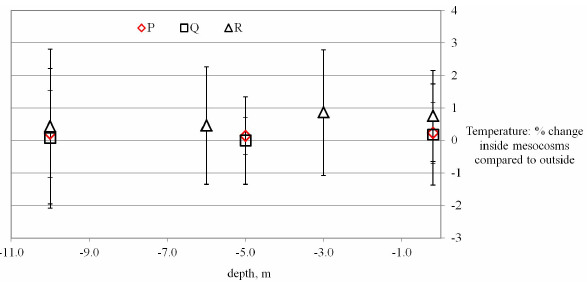
Fig. 6. Evidence of no temperature change inside the mesocosms compared to outside. The temperature was continuously moni- tored inside and outside the mesocosms. The percentage change [100 × (temperature inside – temperature outside)/temperature out- side] is reported for the depths at which the sensors were installed. Number of measurements for the three DUNE experiments (see be- low): n = 197 (DUNE-P); n = 337 (Q); n = 453